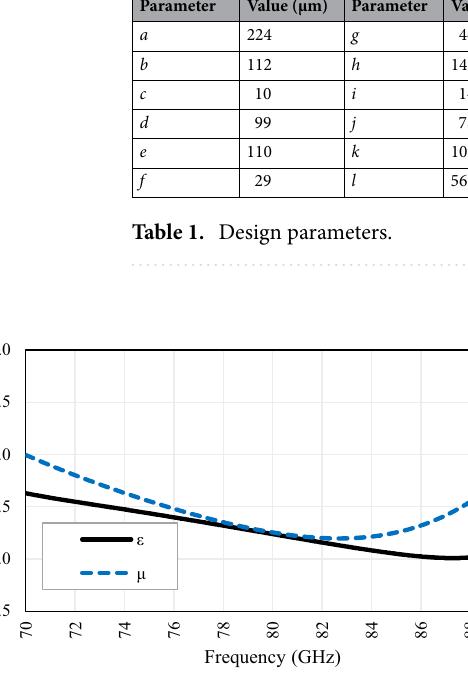
Figure 2. Complex permittivity (ε) and permeability (μ) of proposed flower geometry.